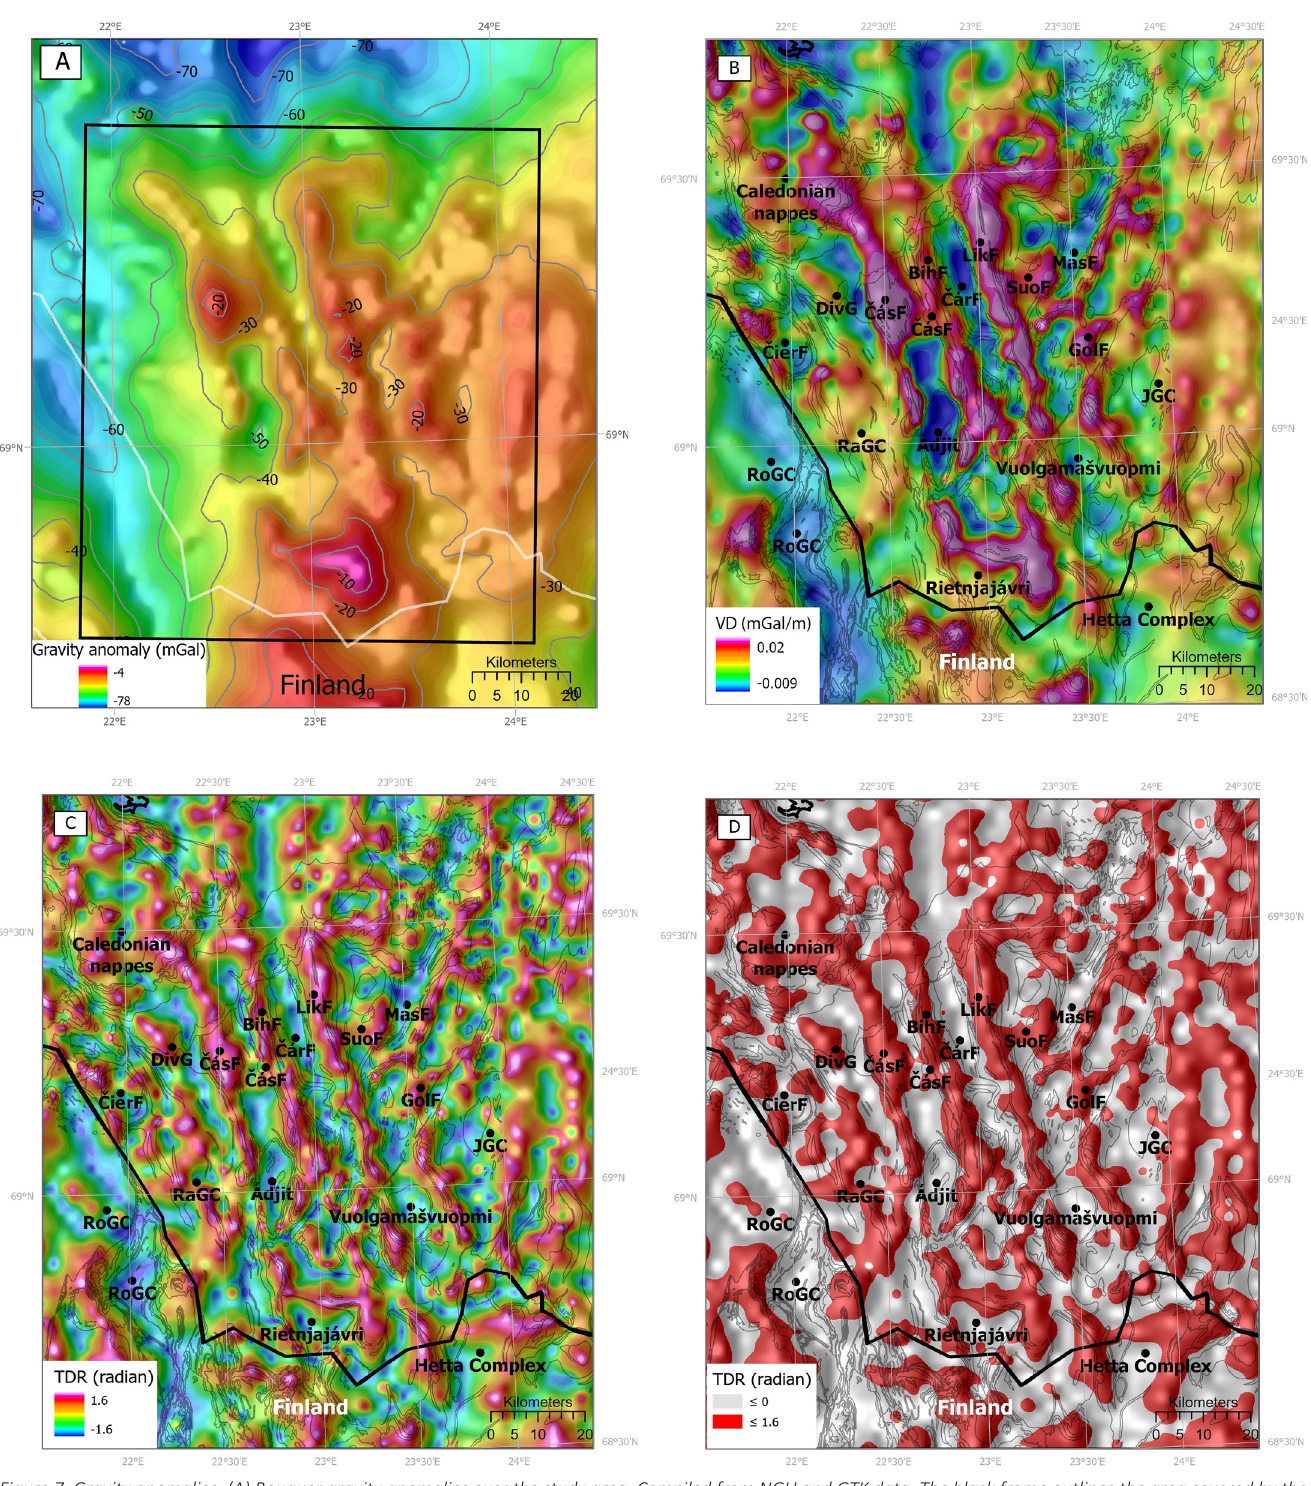
Figure 7. Gravity anomalies. (A) Bouguer gravity anomalies over the study area. Compiled from NGU and GTK data. The black frame outlines the area covered by the 3D model. (B) The first vertical derivative of gravity data. (C) Tilt derivative of a vertical derivative of gravity data. (D) Positive tilt derivative values. BihF= Bihkkačohkka Formation, ČárF= Čáravárri Formation, ČásF= Čáskejas Formation, ČierF= Čierte Formation, DivG= Dividal Group, GolF= Goldenvárri Formation, JGC= Jergul Gneiss Complex, LikF= Likčá Formation, MasF= Masi Formation, RaGC= Ráiseatnu Complex, RoGC= Rommaeno Gneiss Complex, SuoF= Suolovuopmi